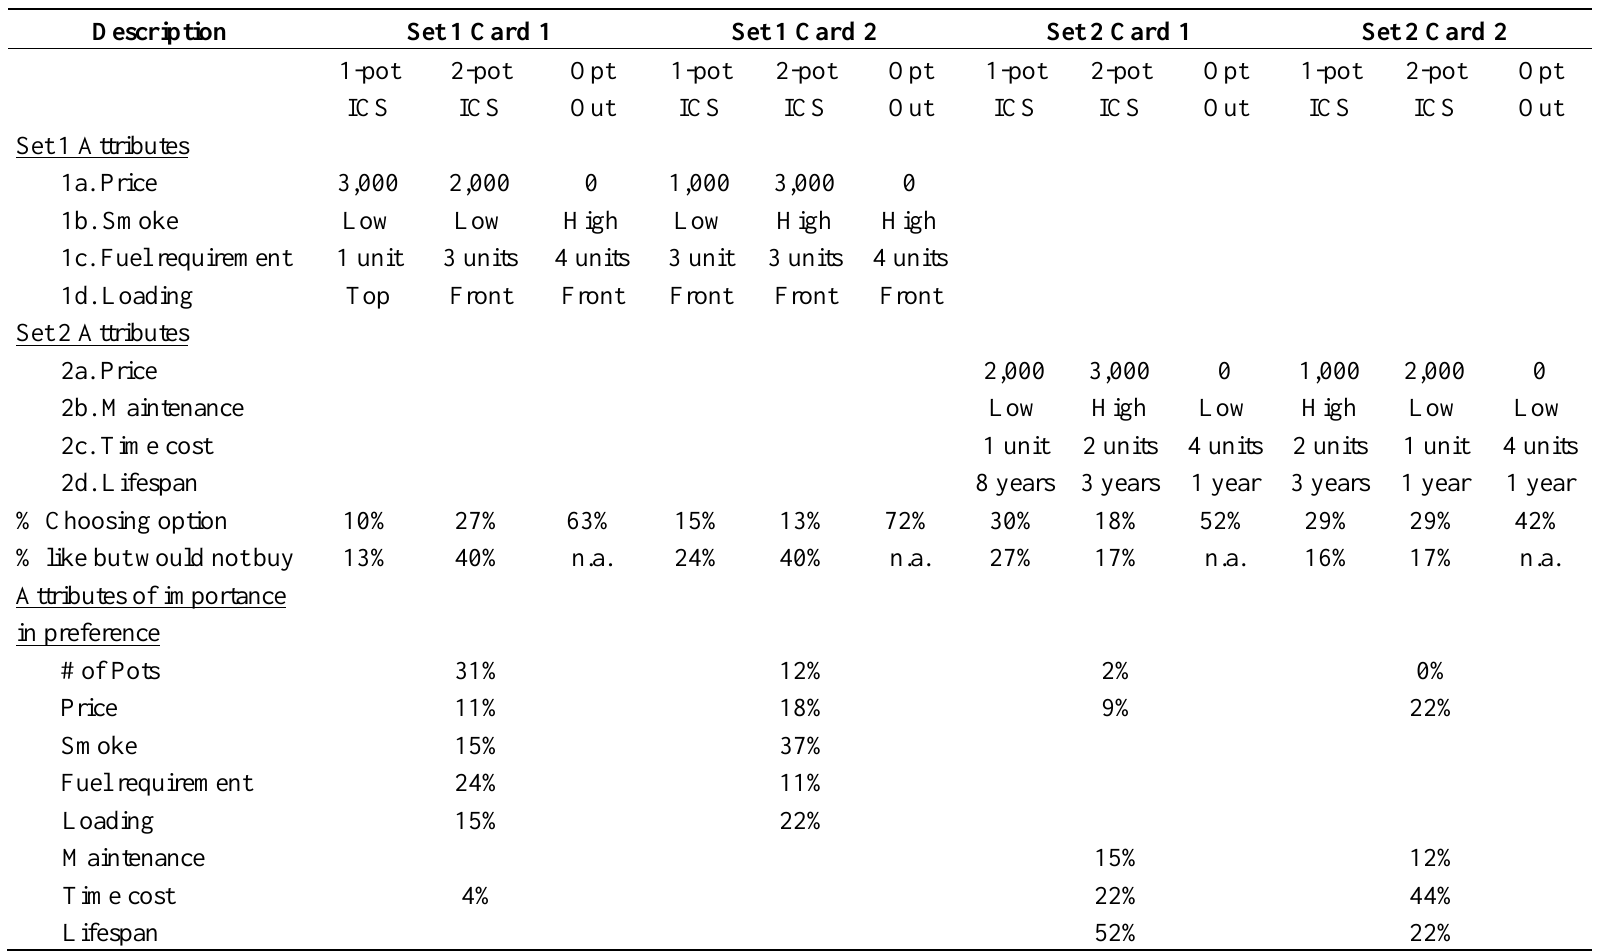
Table 4. Summary of results from stove decision